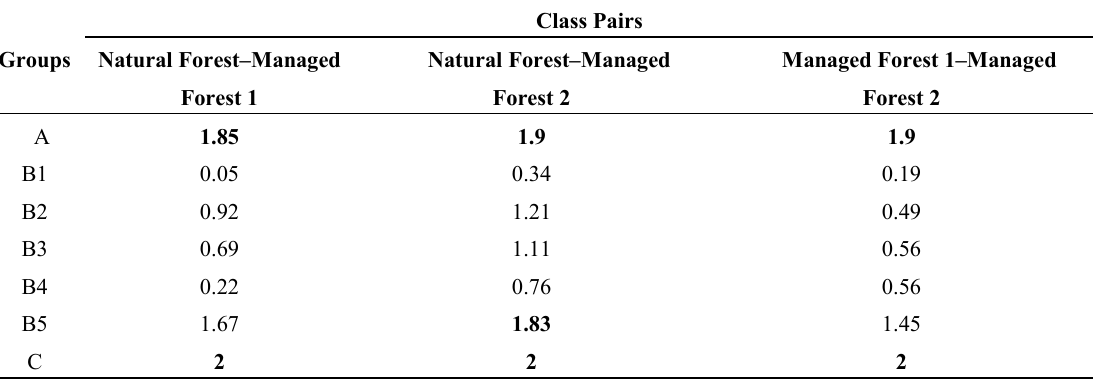
Table 7. Transformed divergence (TD) index for different forest class pairs, TD values higher than the threshold (TD ≥ 1.8) are in